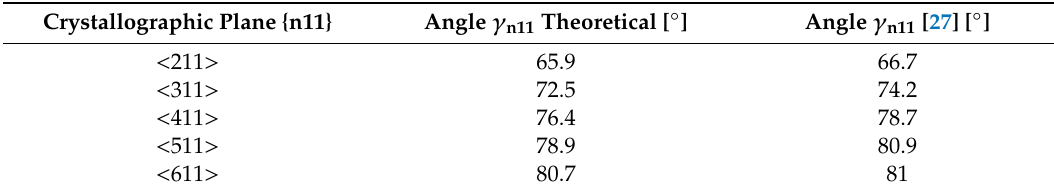
Figure 3. Schematic mask patterns and SEM micrographs (standard Si wafer) of the etched parallelograms with sides along < 100 > directions, ( a ) < 610 > directions, and ( b ) < 710 > directions. Parallelograms are islands of the masking layer (black). Enlarged details of the etched acute and obtuse angles in the masking layer are given for both cases. Magnified {611} and {711} planes are presented. Table 2. The values of angles of inclination γ n11